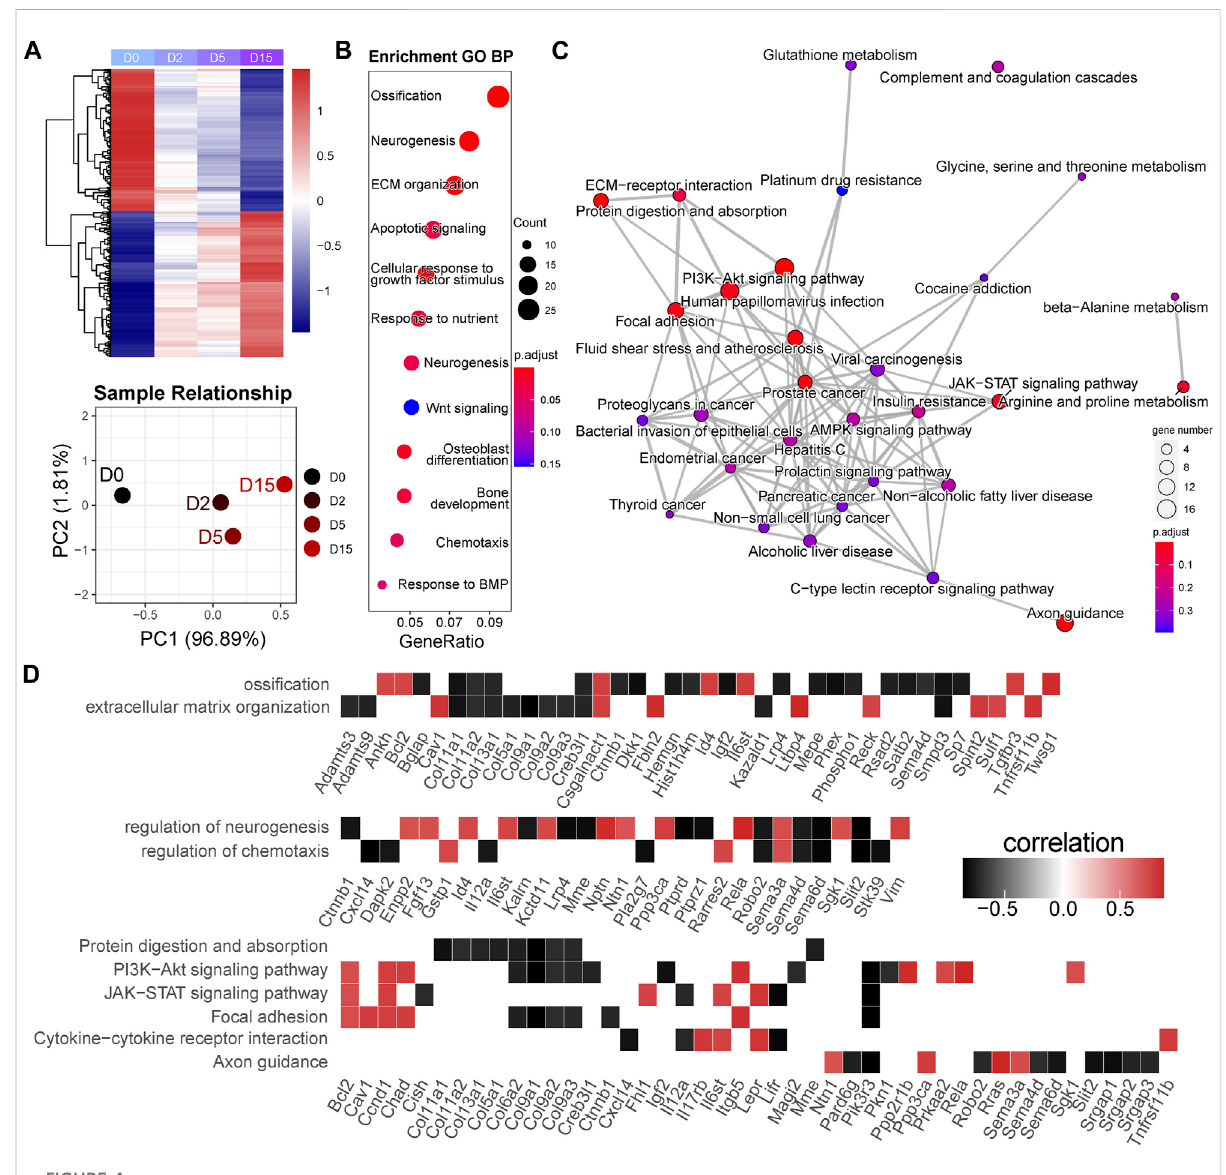
FIGURE 4 Earlyresponsivegenesarerelatedtothecriticaleventsandsignalingpathwaysforcartilagehomeostasis. (A) Heatmapandprincipalcomponent analysis of early responsive genes ( n = 2,477). A clear difference between D0 and D2 or D5. PC1, the fi rst principal component; PC2, the second principalcomponent. (B) GOanalysisofearlyresponsivegenes.GeneRatioindicatesthegenenumberrationineachGOfunction.Thecolorandsize of dot represent p -value adjusted by Benjamini and Hochberg method and gene number assigned to the corresponding GO function, respectively. (C) Pathway network generated by KEGG analysis of early responsive genes. The color and size of dot represent p -value adjusted by Benjamini and Hochberg method and gene number assigned to the corresponding GO function, respectively. (D) Time correlation of genes in the enriched GO function and KEGG